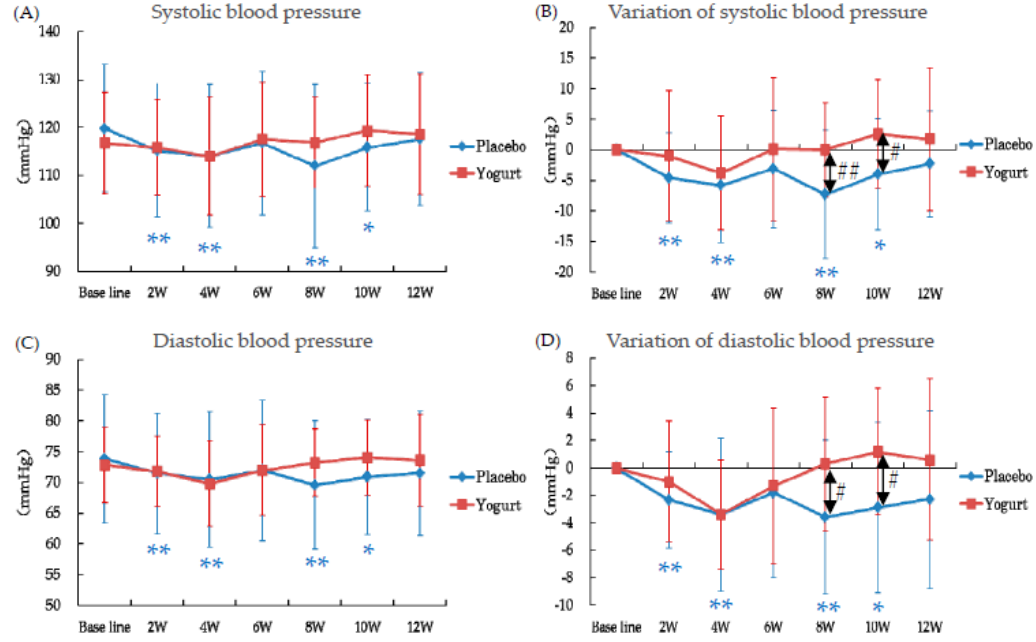
Figure 6. Effects of intake of yogurt fermented with L. bulgaricus OLL1073R-1 on systolic blood pressure ( A ), variation of systolic blood pressure ( B ), diastolic blood pressure ( C ), and variation of diastolic blood pressure ( D ). Data are mean ± standard deviation. * p < 0.05, ** p < 0.01 compared to the baseline by paired t ‐ test. # p < 0.05 between the groups by t ‐ test. ## p < 0.01 between the groups by t ‐ test.